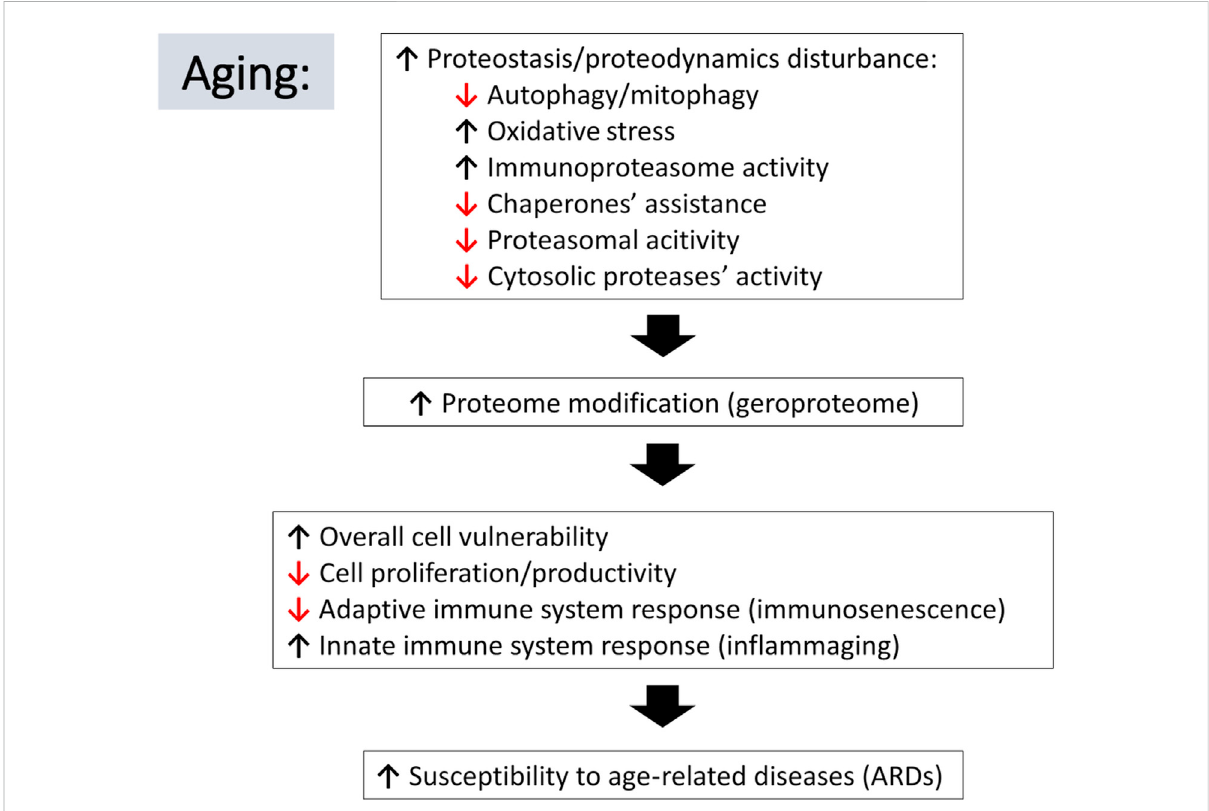
FIGURE 2 Schematic representation of relations between aging-associated changes in proteostasis/proteodynamics leading to modi fi cation of cellular proteomes and resulting in adverse consequences leading to the aging-related diseases. Arrow pointing down indicates a decline in the listed process, whereas an arrow pointing up suggests an